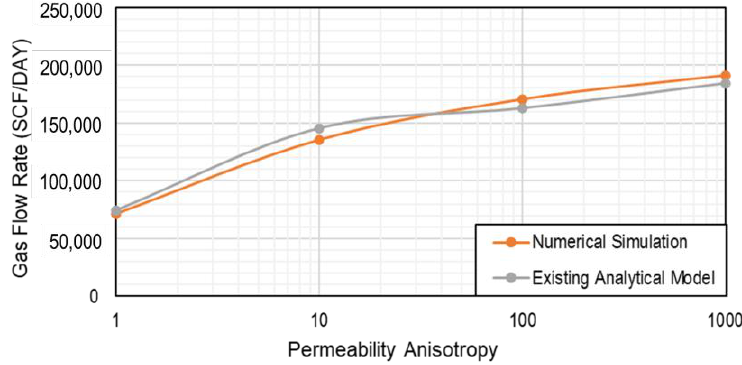
Figure 4. The effect of the length of branches on the cumulative gas production.